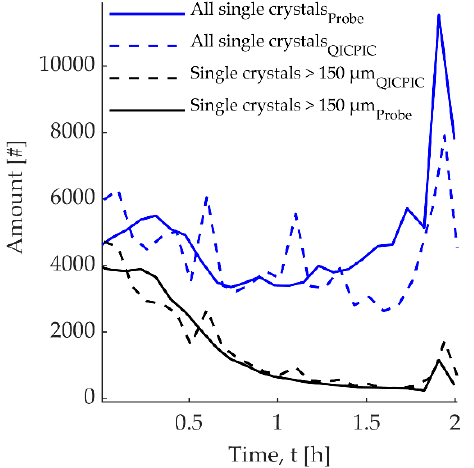
Figure A8. ( a ) Temperature profile of the Exp. 2 - KH 2 PO 4 : saturation, seeding, linear cooling ramp and final temperature. ( b ) Concentration profile of Exp. 3 - KH 2 PO 4 : FTIR, offline samples and saturation curve.